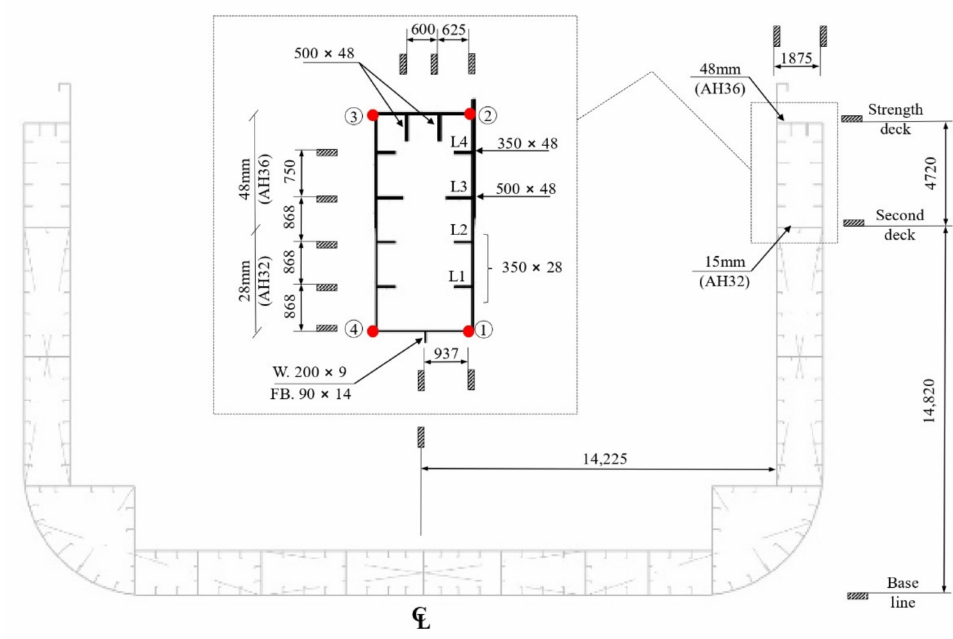
Figure 2. Midship section and torsion box detail (dimensions in mm).